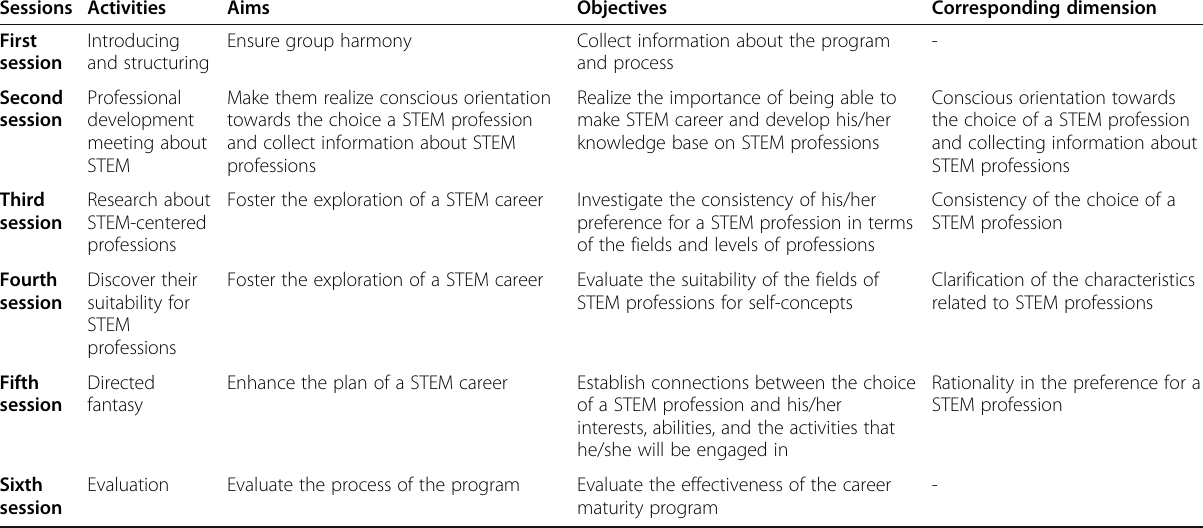
Table 2 Content of the STEM career maturity